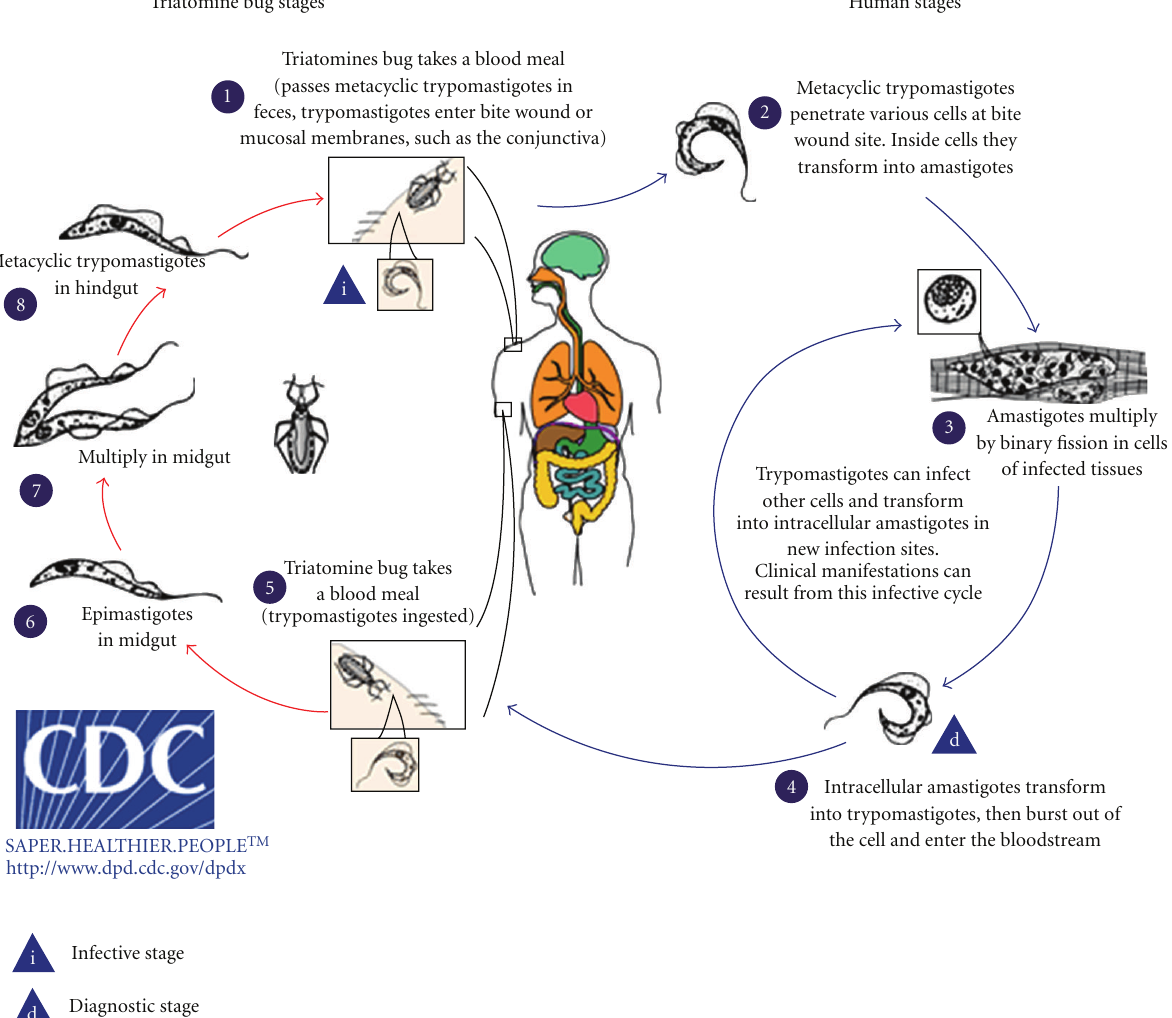
Figure 1: Life cycle of T. cruzi showing the various forms of the protozoan in the invertebrate (triatomines) and vertebrate (mammals) hosts. Figure reproduced from the Center of Control Diseases